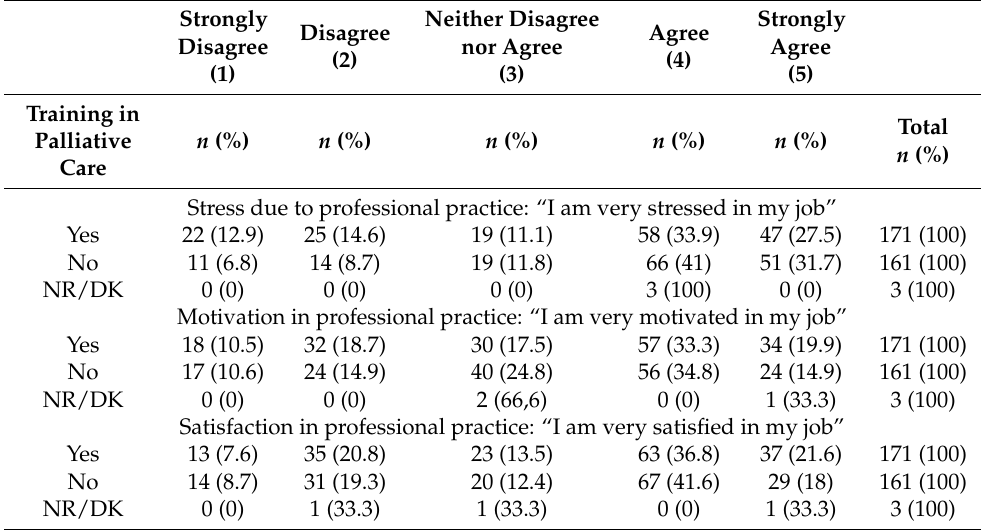
Table 3. Satisfaction, stress, and motivation based on their training in palliative